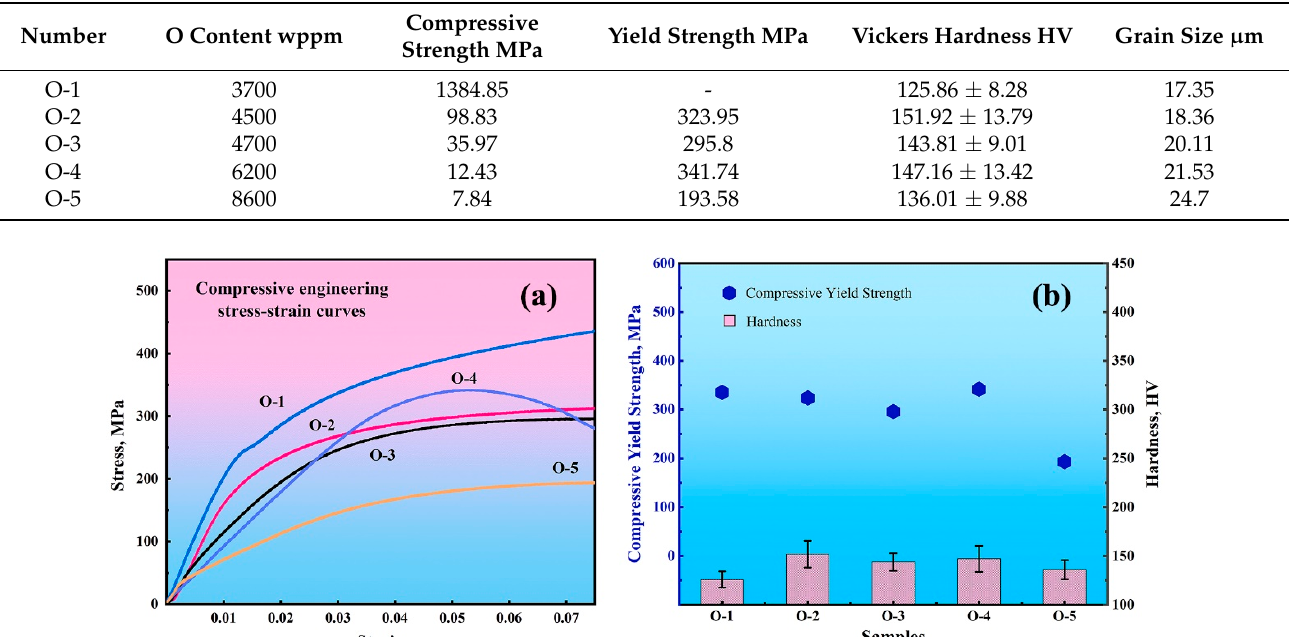
Table 4. Mechanical properties and grain size of sintered Mo specimens.